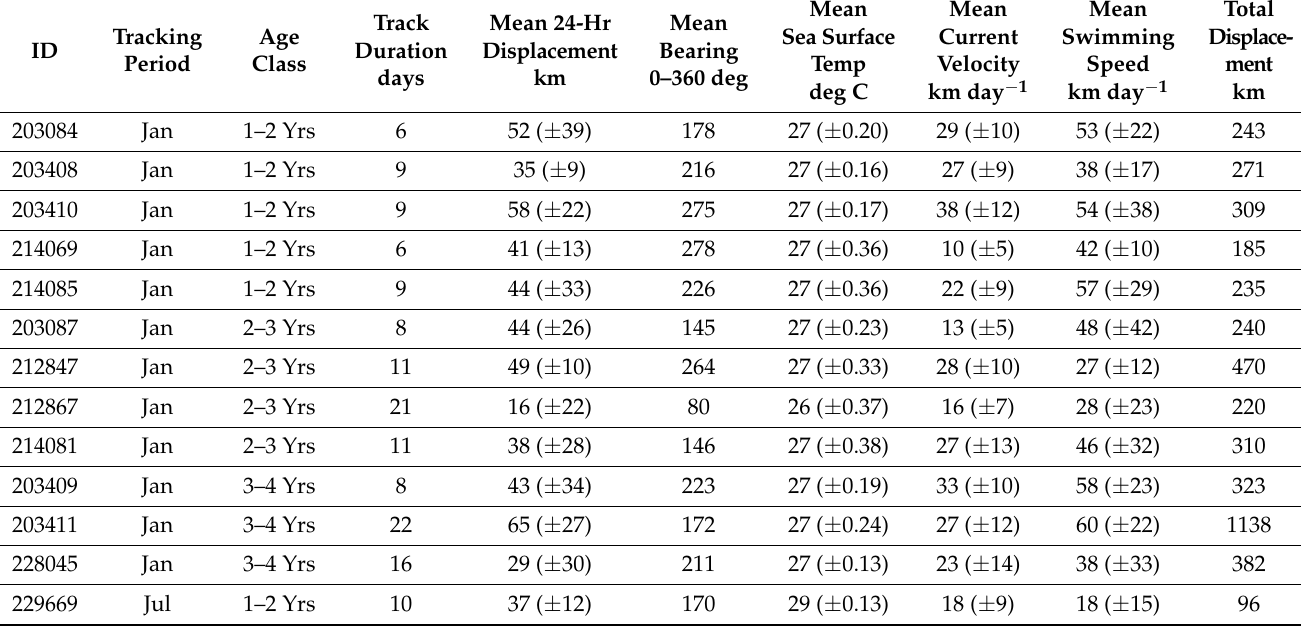
Table 1. Summary statistics for the daily locations of dispersive individuals ( N = 22), with columns for: tracking period (January and July), age class (1–2, 2–3, and 3–4 yrs), track duration (days,